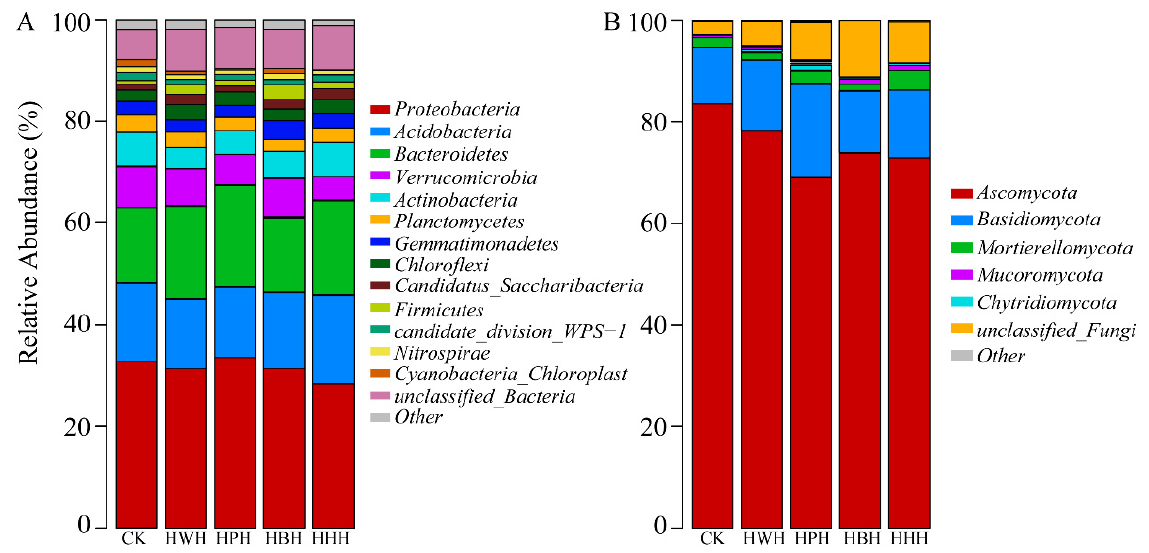
Figure 5. The relative abundance of bacterial ( A ) and fungal ( B ) communities at the phylum level under different culture conditions.